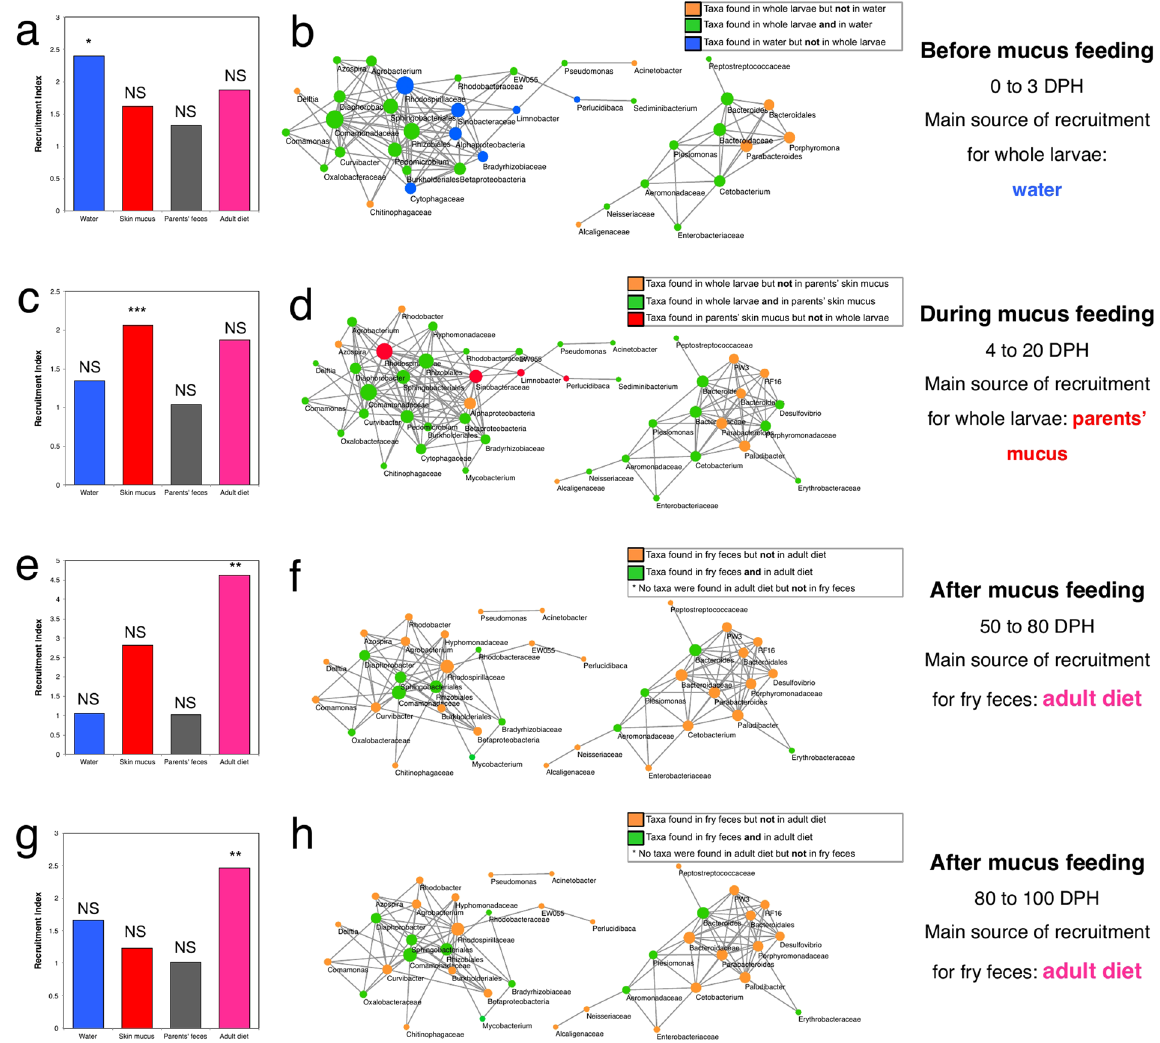
Figure 3. Microbial taxa from water and skin mucus are drivers of whole fry and fry feces microbiota. In ( b , d , f and h ) co-abundance based networks of the 50 most abundant OTUs, constructed with Cytoscape v. 3.2.1. Each dot (node) and its label represent an OTU defined at the lowest level possible. A link (edge) between two nodes highlights a Spearman correlation index > 0.9 between the two taxa and a p-value < 0.0001 (corrected with Bonferroni). The size of each node is proportional to the number of edges that it is connected to. In ( a , c , e and g ) bar charts representing the recruitment index (see Methods section for details on calculation) from each of the environmental microbial reservoirs (water, parents’ mucus, adult diet), at the four life stages of the fry: before mucus feeding (0–3 DPH), during mucus feeding (4–20 DPH), early post-mucus feeding (50–80 DPH), and late post-mucus feeding (80–100 DPH). Recruitment from water is represented by blue bars, recruitment from skin mucus is red, recruitment from parental feces is grey, and recruitment from the adult diet is